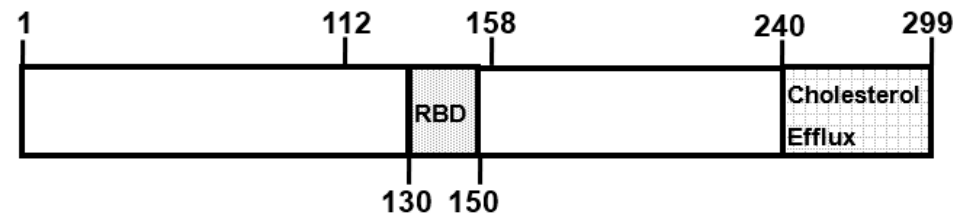
Figure 2. Domains of human apoE. The LDL receptor-binding domain (RBD) is located between residues 130 and 150 and the cholesterol efflux domain between residues 240 and 299. The apoE isoforms differ in the amino acids at positions 112 and 158. Both residues are arginines in apoE4, cysteines in apoE2, and cysteine at 112 and arginine at 158 in